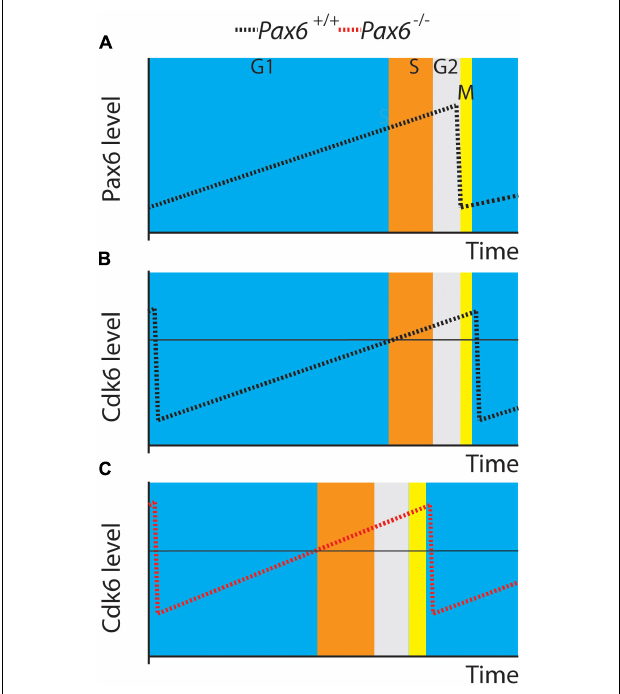
FIGURE 6 | A model. (A,B) Pax6 and Cdk6 oscillations are slightly out of phase. (C) A general elevation of Cdk6 activity throughout the cell cycle might allow levels critical for switching from G1 to S (horizontal line in B,C ) to be achieved more rapidly than